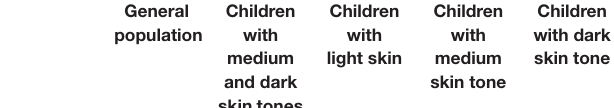
TABLE 5 | Estimated annual risks of having rickets and rickets incidence rates by skin tone (observational dataset). General Children population with